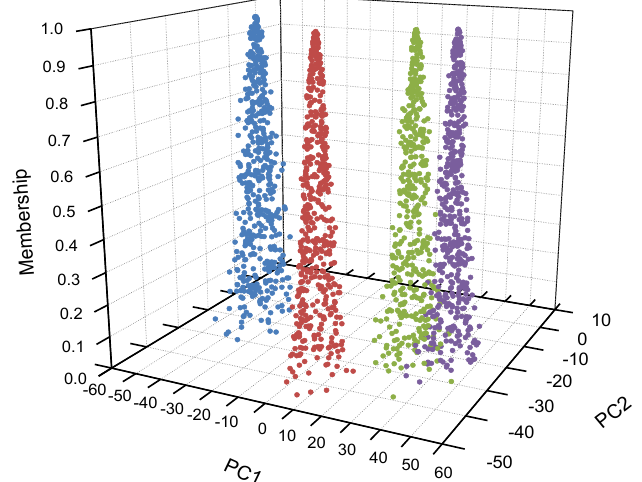
Figure 3. Cloud drop results of four different flavor types of liquor (●: jiang-flavor style, ●: feng-flavor style, ●:nong-flavor style, ●: mild-flavor style).